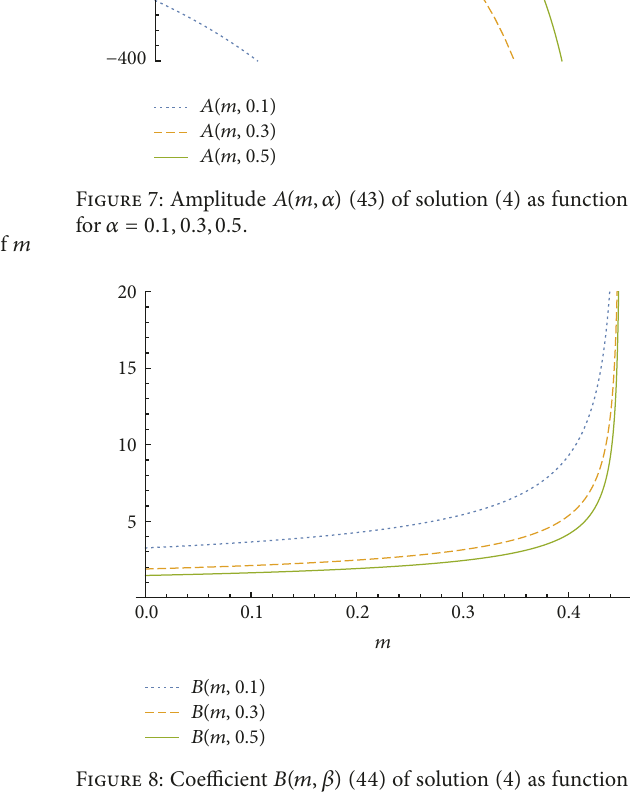
Figure 8: Coefficient 𝐵(𝑚,𝛽) (44) of solution (4) as function of 𝑚 for 𝛽 = 0.1, 0.3, 0.5 .